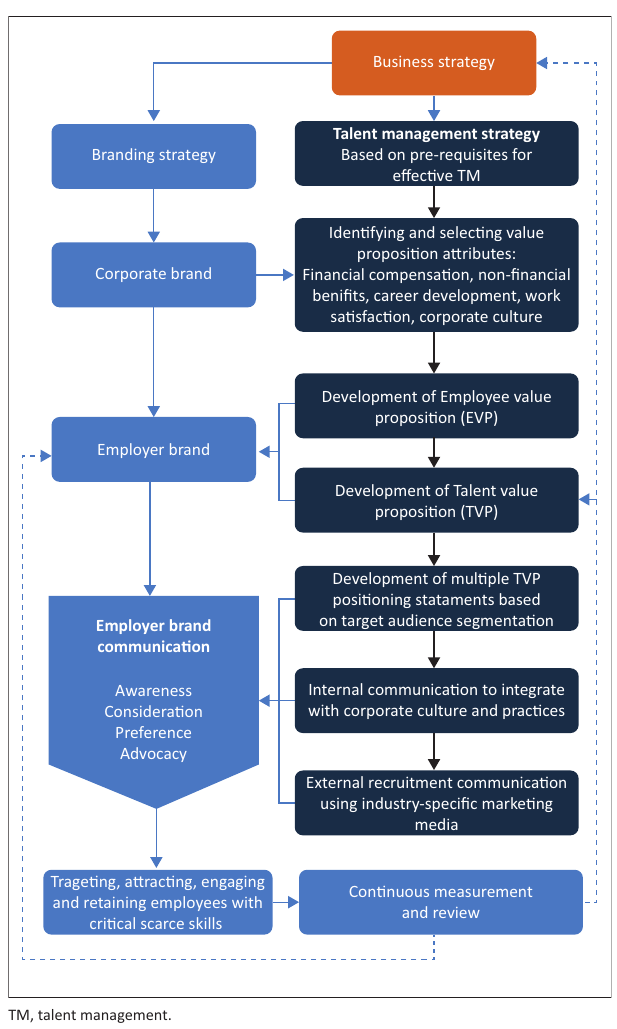
FIGURE 1: An employee value proposition